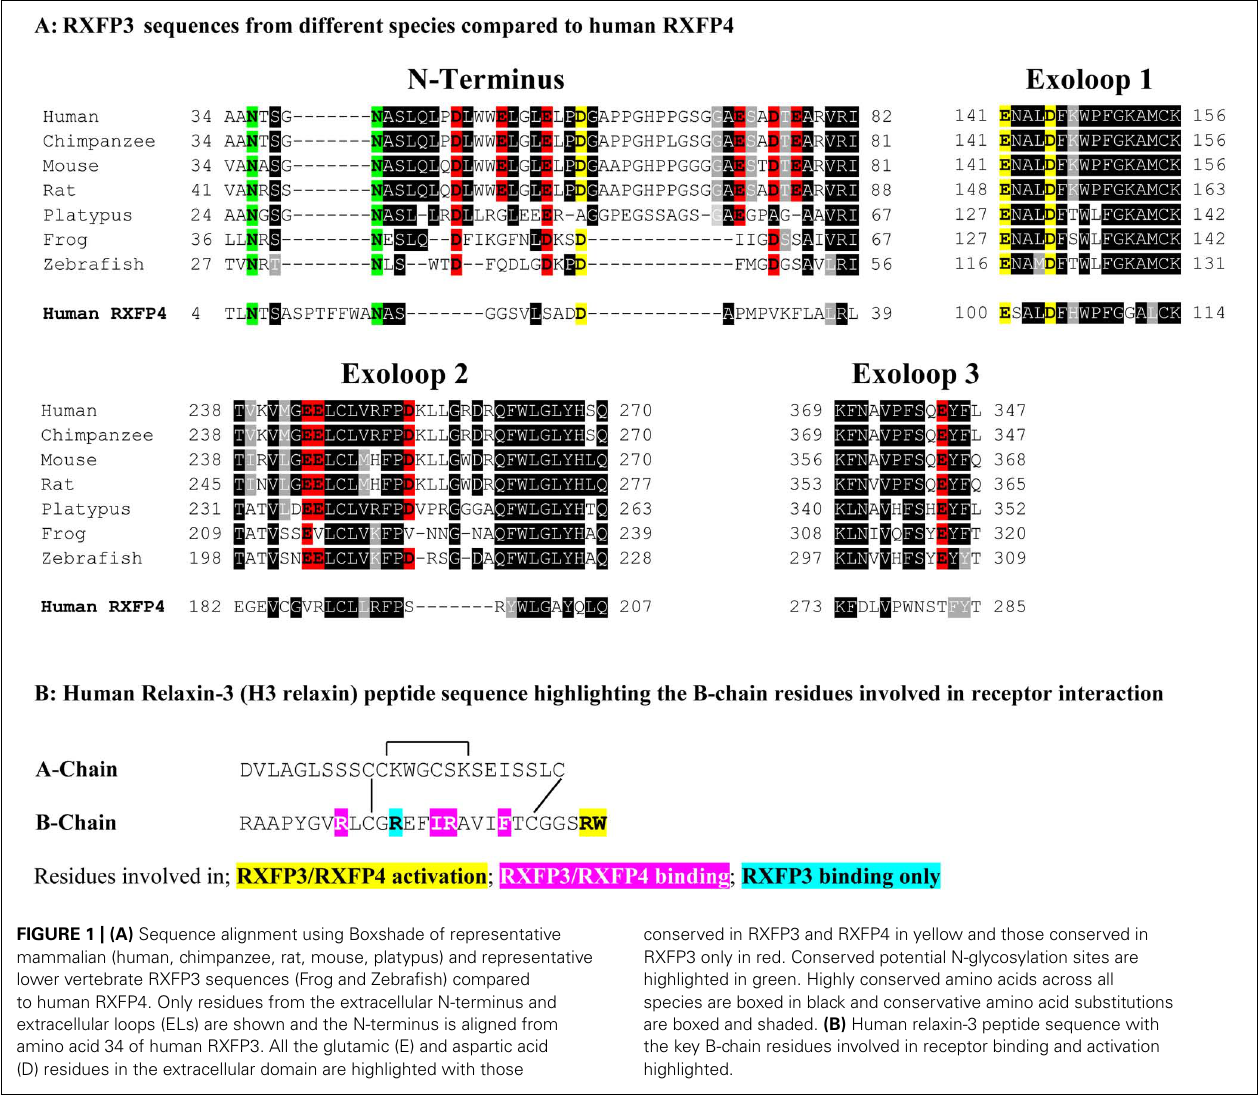
conserved in RXFP3 and RXFP4 in yellow and those conserved in RXFP3 only in red. Conserved potential N-glycosylation sites are highlighted in green. Highly conserved amino acids across all species are boxed in black and conservative amino acid substitutions are boxed and shaded. (B) Human relaxin-3 peptide sequence with the key B-chain residues involved in receptor binding and activation